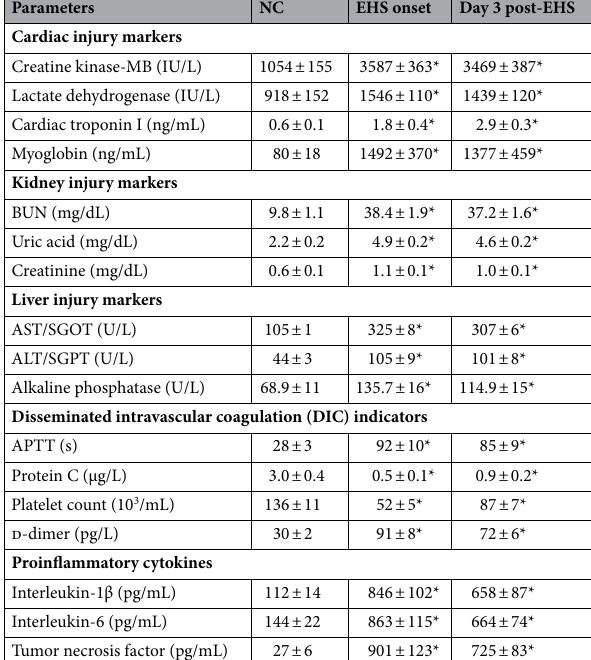
Table 1. The mean ± S.D. values (n = 8 for each group) of cardiac injury markers, kidney injury markers, liver injury markers, and disseminated intravascular coagulation (DIC) markers for NC, EHS onset, and Day 3 post- EHS. *P < 0.05, EHS onset vs. NC or Day 3 post-EHS vs.